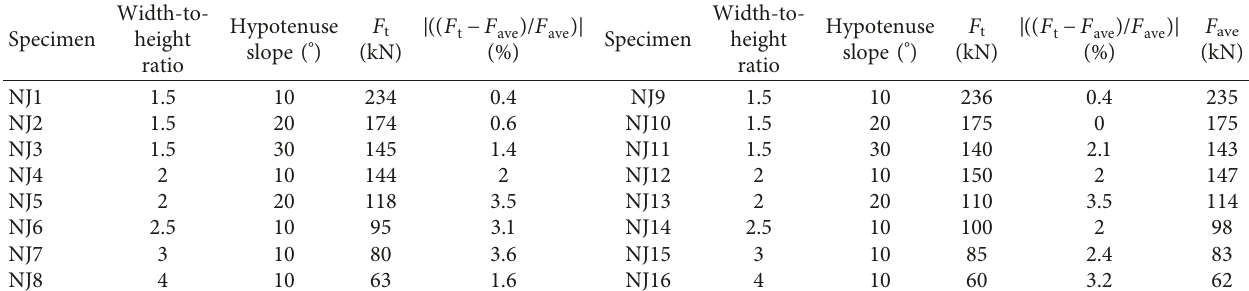
Table 5: Comparison of the uplift bearing capacity for the test